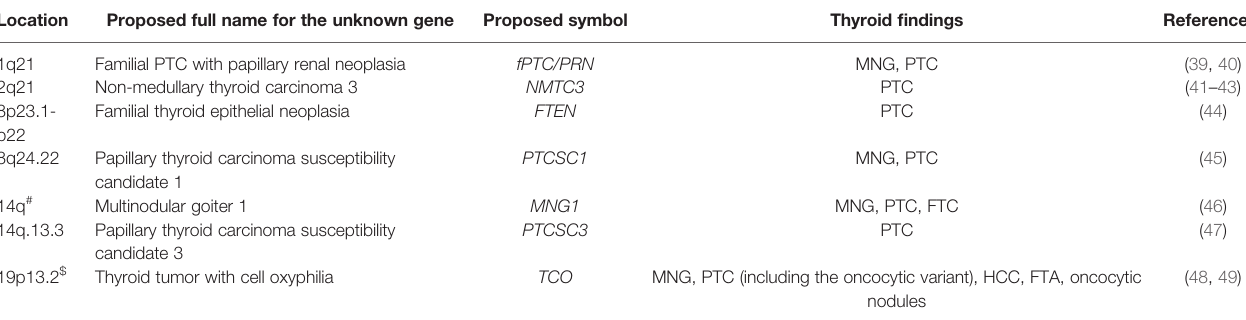
TABLE 2 | Chromosomal loci associated with non-syndromic familial non-medullary thyroid tumors.